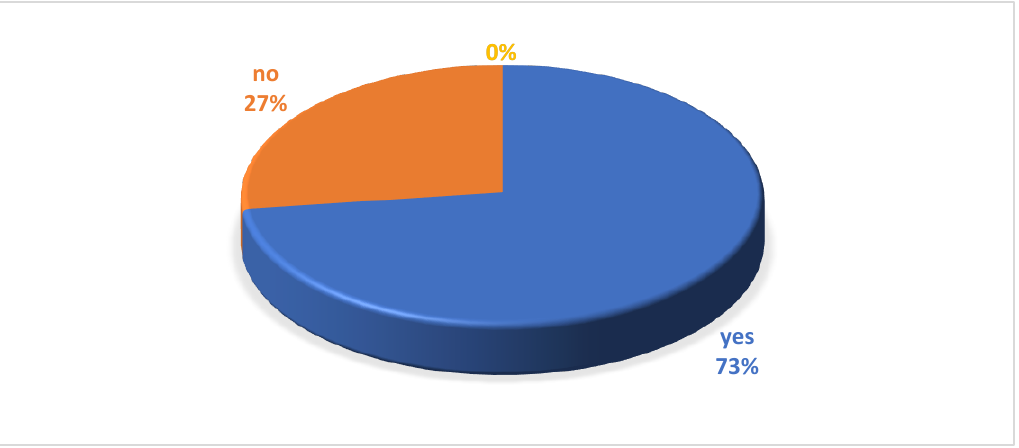
Figure 6. Development of a low-emission economy map by the commune (for this or this year).